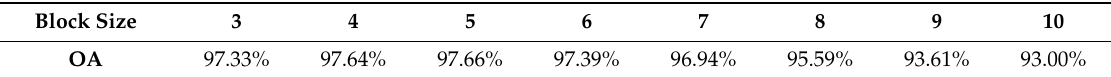
Table 6. Overall classification accuracy of different block sizes.